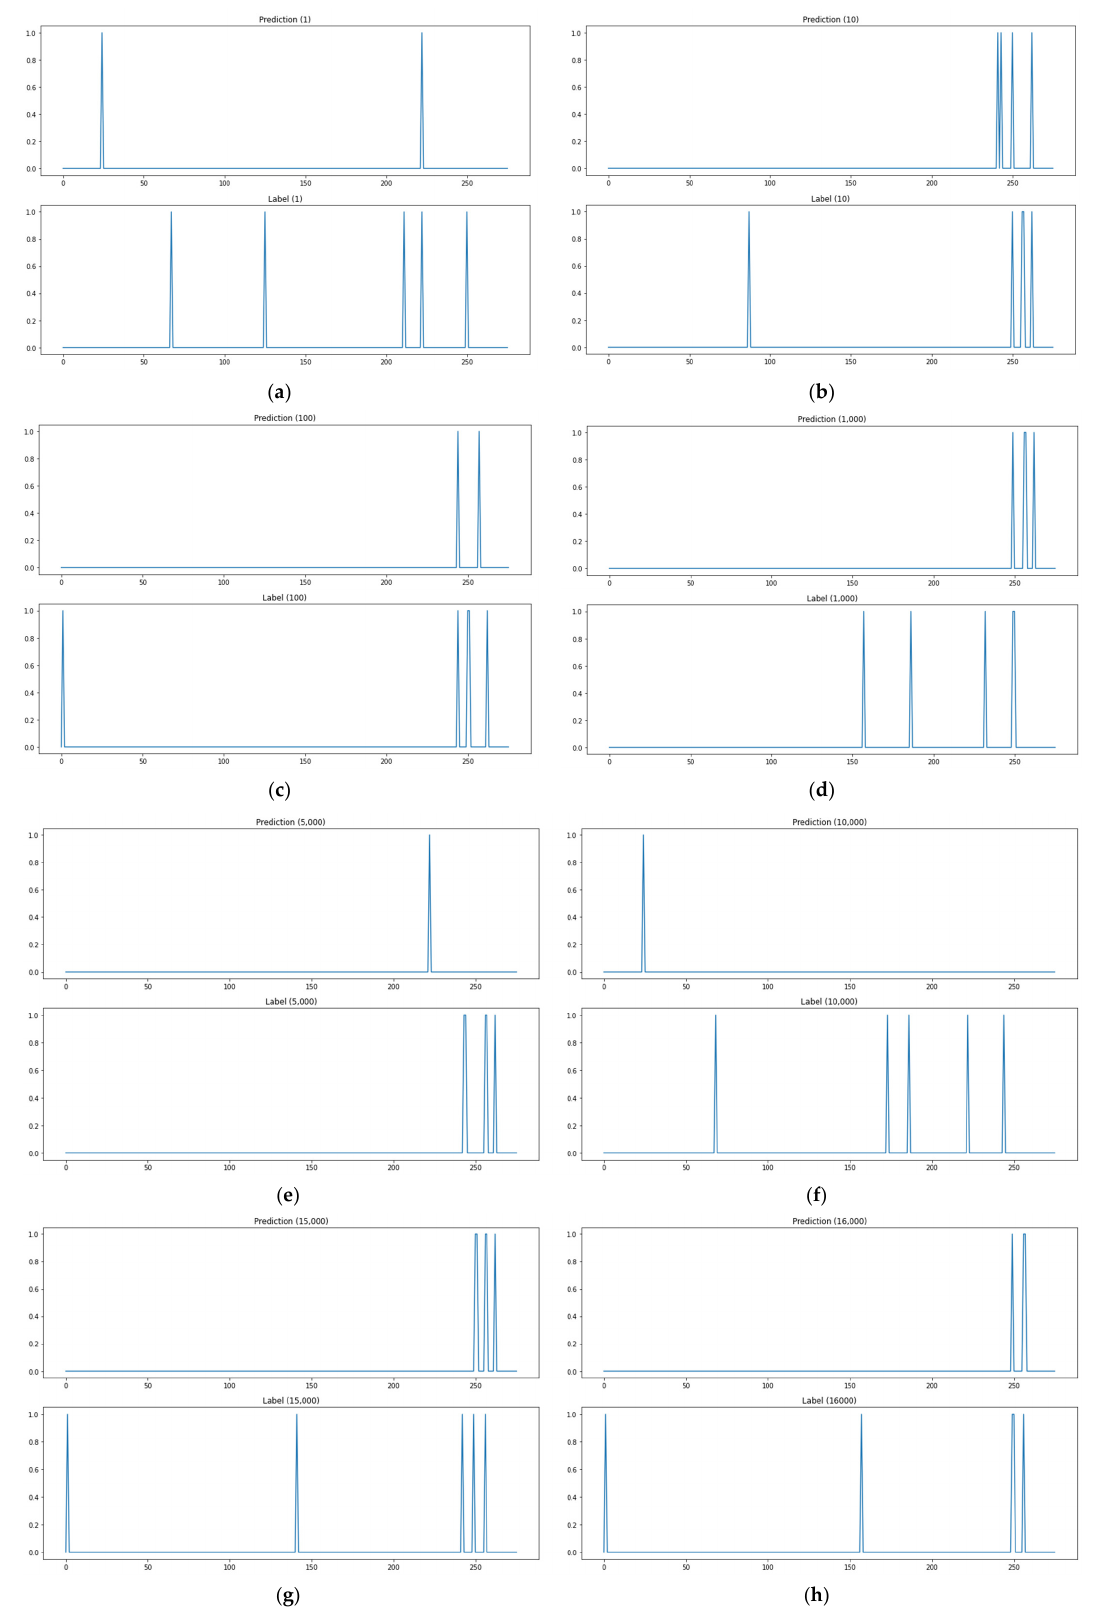
Figure 9. Example of the classification and prediction model results. ( a ) Classification model. ( b ) Prediction model.